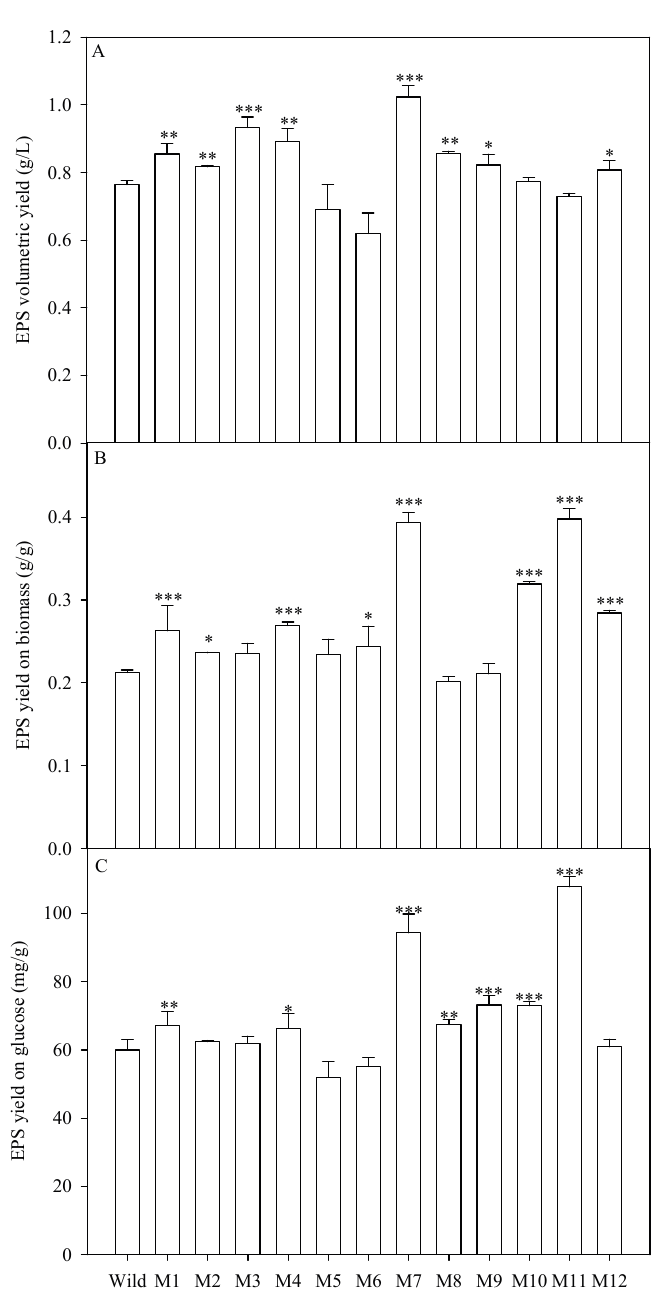
Figure 4. EPS yield of the wild type and 12 mutants of C. cohnii . ( A ) EPS volumetric yield; ( B ) EPS yield on biomass; ( C ) EPS yield on glucose; asterisk (* p < 0.05, ** p < 0.01, and *** p < 0.001) means significant differences between wild type and the